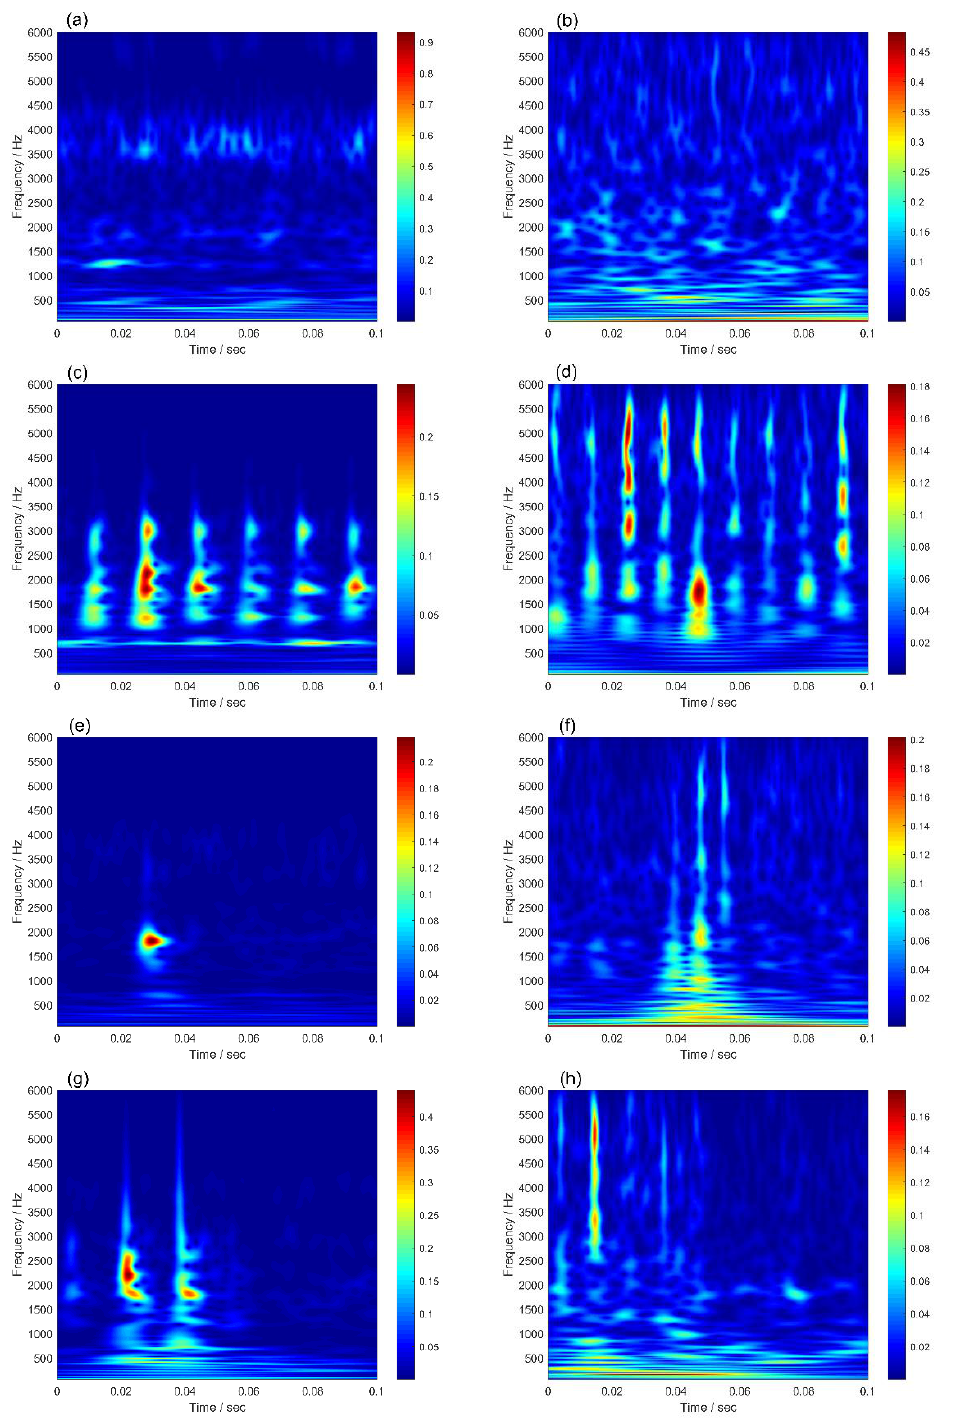
Figure 11. Time–frequency diagram of measured and simulated signals: ( a ) N of the measured signal; ( b ) N of the simulated signal; ( c ) OF of the measured signal; ( d ) OF of the simulated signal; ( e ) IF of the measured signal; ( f ) IF of the simulated signal; ( g ) BF of the measured signal; ( h ) BF of the simulated signal.